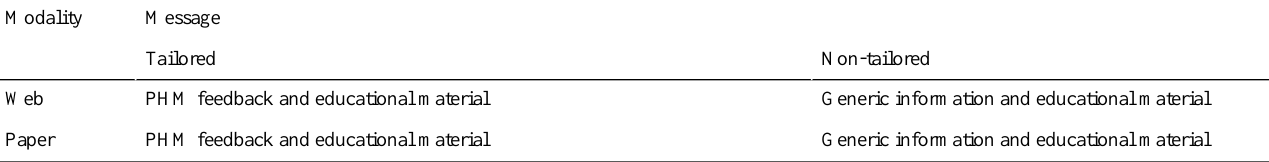
Table 1. Information supplied to intervention group participants based on message type and modality.